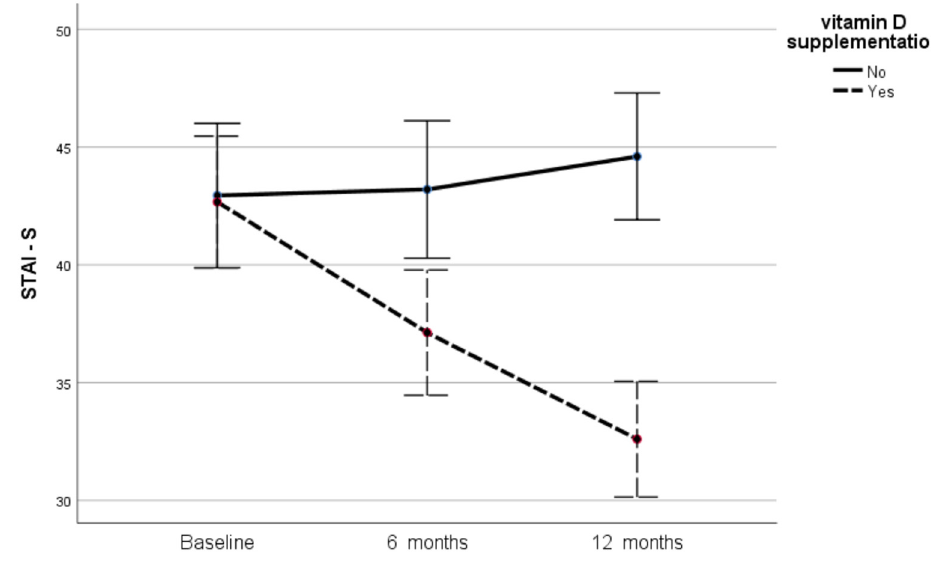
Figure 2. Changes in STAI-S scores in the two groups during the study.